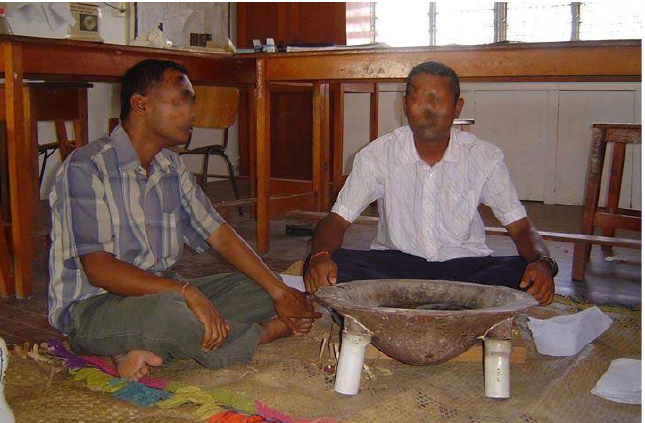
Figure 4: Teachers drinking yaqona during school hours to “support” their students sitting end- of-year exams (photographer: Apo Aporosa, 2009; image altered for confidentiality)